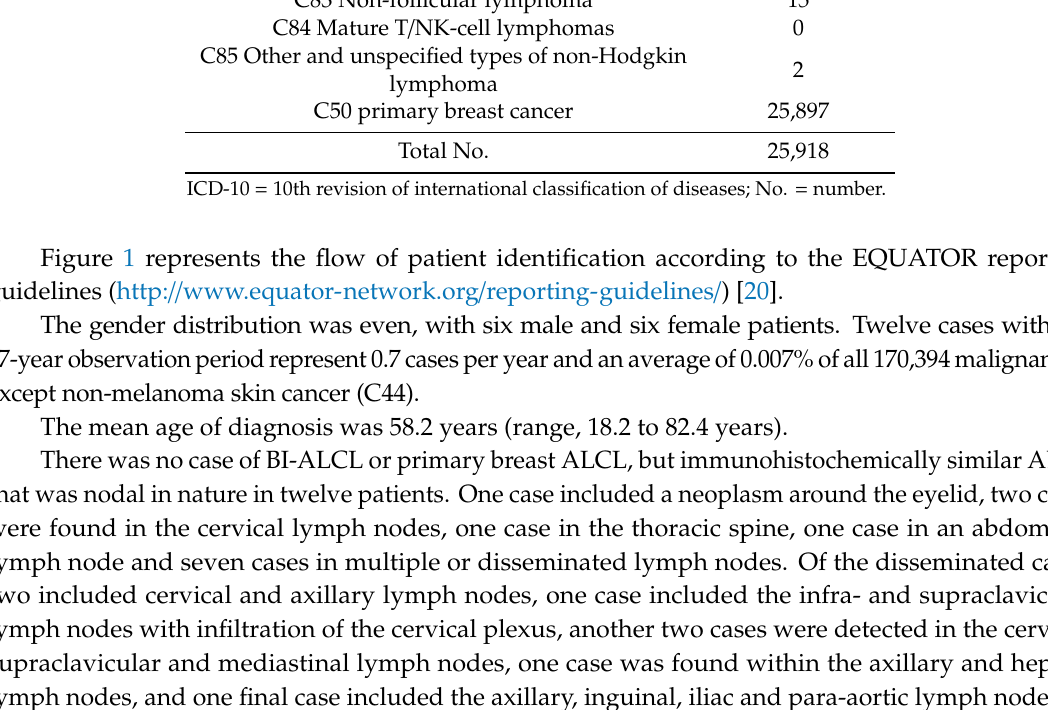
Table 2. Organ-based (breast) search algorithm depicting all malignancies found within the breast tissue. ICD-10 No. of Cases